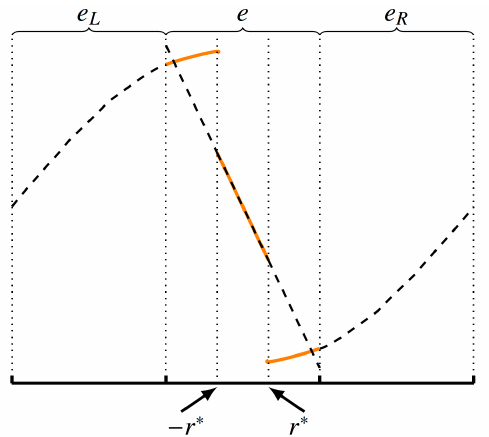
Figure 1. Illustration of the extended MDA sensor. The black dashed line is the original solution. The orange solid line is the modified solution in the current element e